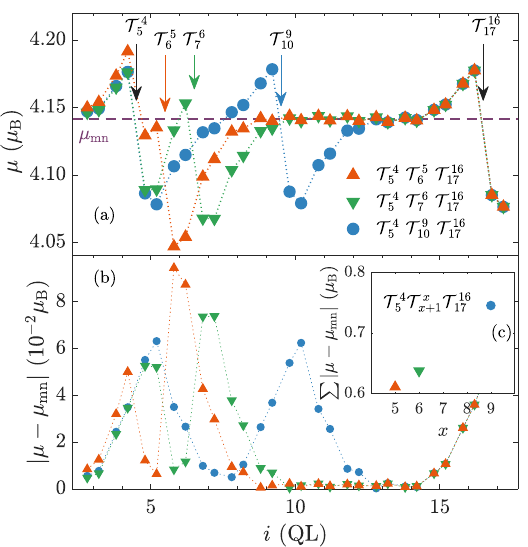
Figure 9. ( a ) Distributions of magnitudes of magnetic moments in homogeneously magnetically doped Bi 1.98 Mn 0.02 Se 3 for various positions of TPs. Mn Bi are labeled by the index i of the appropriate QL. Arrows point to positions of introduced TPs. The outer TPs have fixed positions in all the cases (black arrows). Whereas, the inner one is being moved, the color of the arrow corresponds to the color of the function. ( b ) The absolute value of the change of the magnetic moment with the respect to the mean moment value µ mn . ( c ) The sum of the magnetic moment changes from the previous